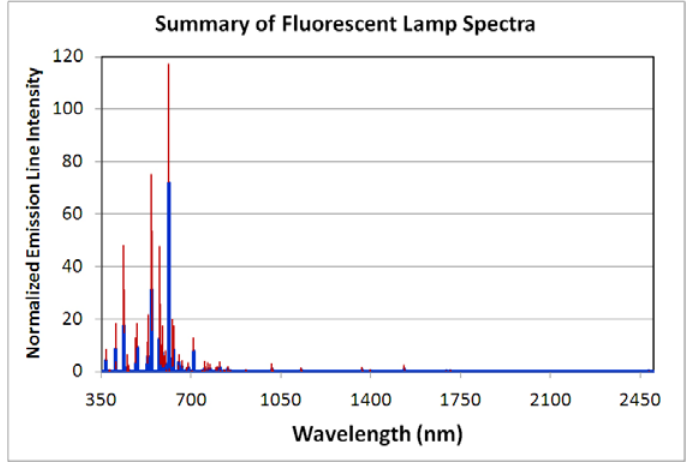
Figure 10. Spectral variability of fluorescent lamps. Each of the nine spectra were normalized to 1.0 and then an average (blue) and standard deviation (red) were